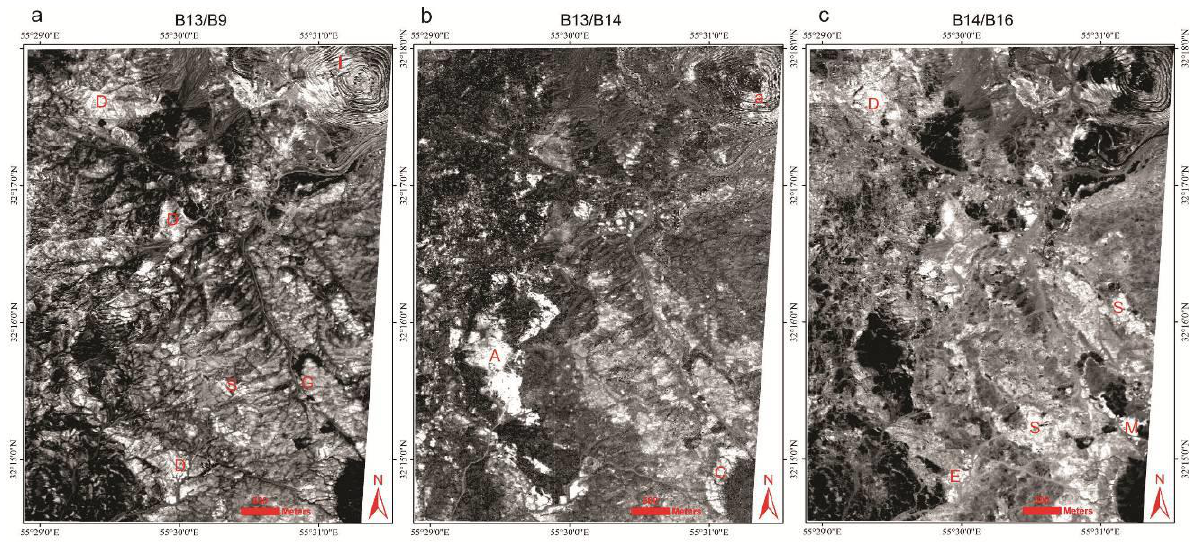
Fig. 5. WV-3 band ratio images of Chadormalu area, central Iran. a. Band 13/band 9 (B13/B9) ratio image highlighting ferrous iron rich rocks including iron ore (I) in the mine, intrusive diorite (D), green schist (S) and gneissic granite (G). b. Band 13/band 14 (B13/B14) ratio image highlighting sericite-rich rocks including albitite granite (a) in the mine, altered granite (A) at the southwest of the study area and alteration along with crushed metamorphosed rocks (C) at the south east of the study area. c. Band 14/band 16 (B14/B16) ratio image highlighting chlorite-epidote rich rocks including intrusive diorite (D), green schist (S) and high Epidotizated rocks (E) at the south part of the study area; Overlap of the Fe-OH and Mg-OH spectral absorption feature with CO 32- spectral absorption feature leads to highlighting dolomitic marble (M) at south east of the study